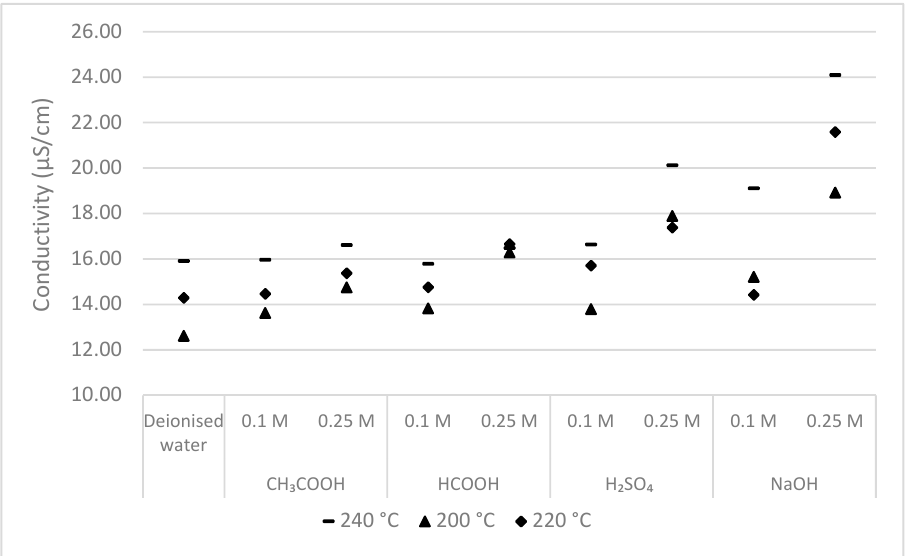
Figure 4. Conductivity of process-water produced using acids and alkali additive at different con- centration.